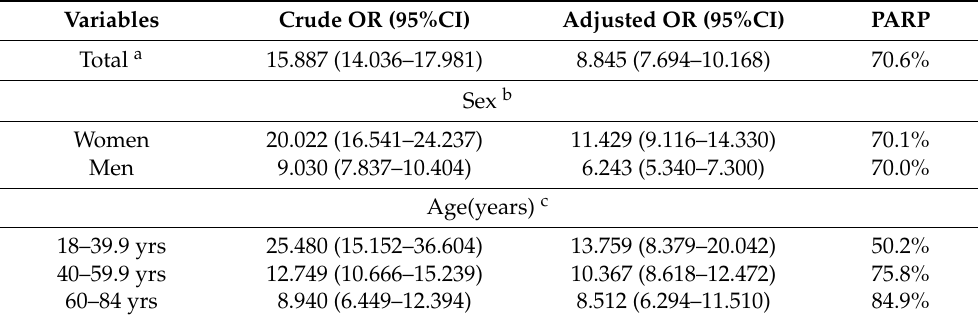
Table 5. ORs (95%CI) in the multiple logistic regression model and PARP of arteriosclerosis based on optimal cut-off points for blood